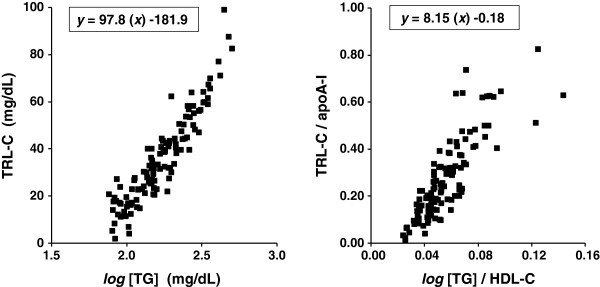
Equivalence between tests.Left panel: plots of untransformed values of log[triglycerides (TG)] (X axis) vs. TG-rich lipoprotein cholesterol (TRL-C) (Y axis). Right panel: plots of log[TG]/high-density lipoprotein cholesterol (HDL-C) (X axis) vs. TRL-C/apolipoprotein (apo) A-I (Y axis). The equations of the two unbiased lines of equivalence relating each pair of measurements are provided on the graphs. All values obtained from the means of nonfasting values measured on two different days in 120 patients with type 2 diabetes mellitus.